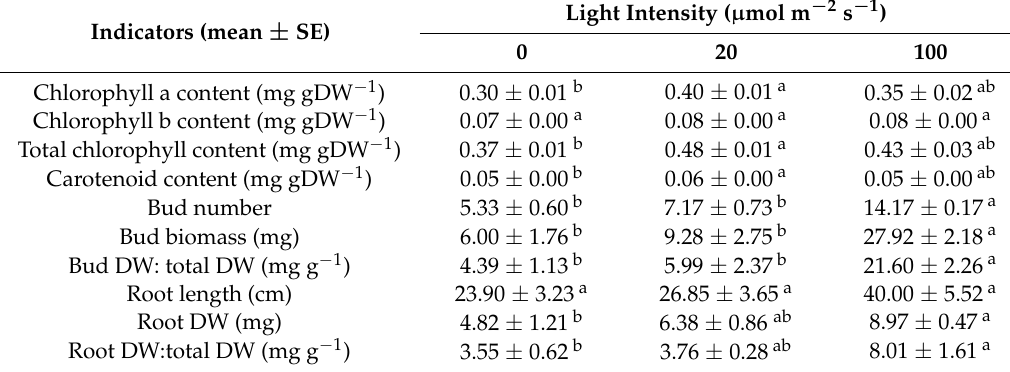
Table 1. Stem photosynthetic pigments contents and organ growth of the cutting seedlings exposed to different light intensities. The different lowercase letters in the same row indicate significant ( p < 0.05) differences between light intensity treatments.